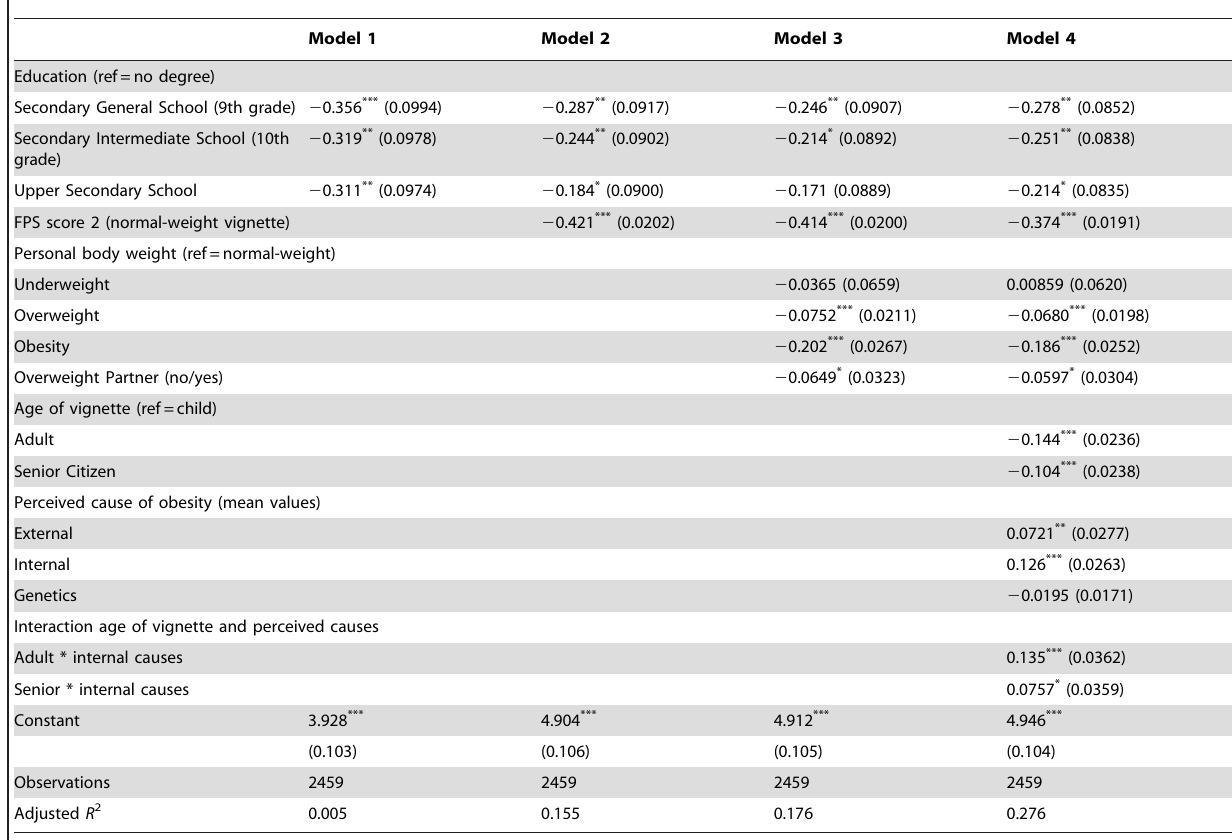
Table 6. Prediction of stigmatizing